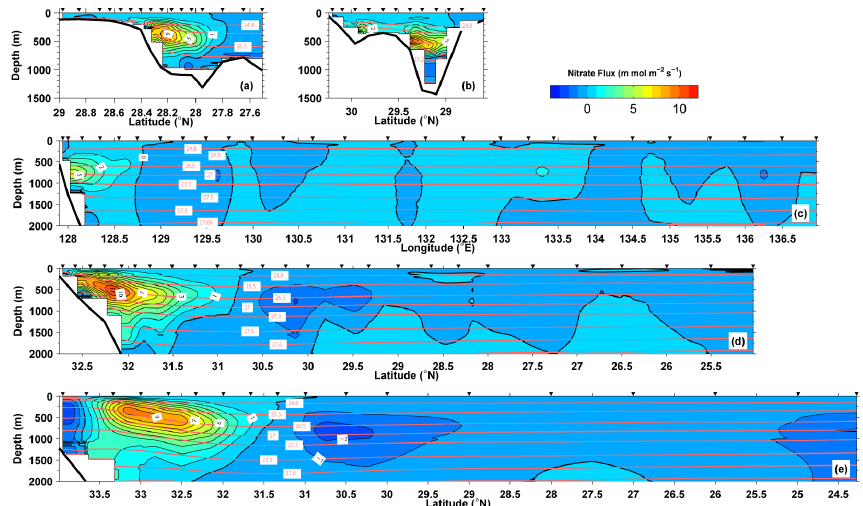
Fig. 4. Temporally averaged nitrate flux (mmolm − 2 s − 1 ) for all sections. Colored areas and black contours indicate the nitrate flux with an interval of 1mmolm − 2 s − 1 . Positive values of velocity are defined as in Fig. 3. Red contours indicate the eight isopycnal layers. Thick black lines indicate zero nitrate flux. The inverse triangles are the same as those in Fig.